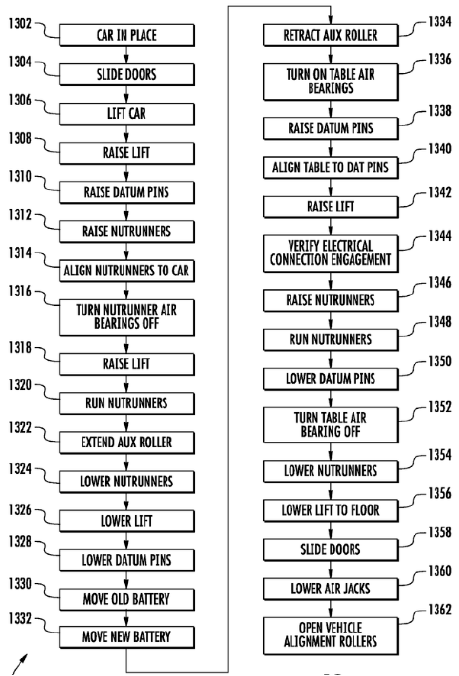
Figure 3. Battery swapping procedure flow chart